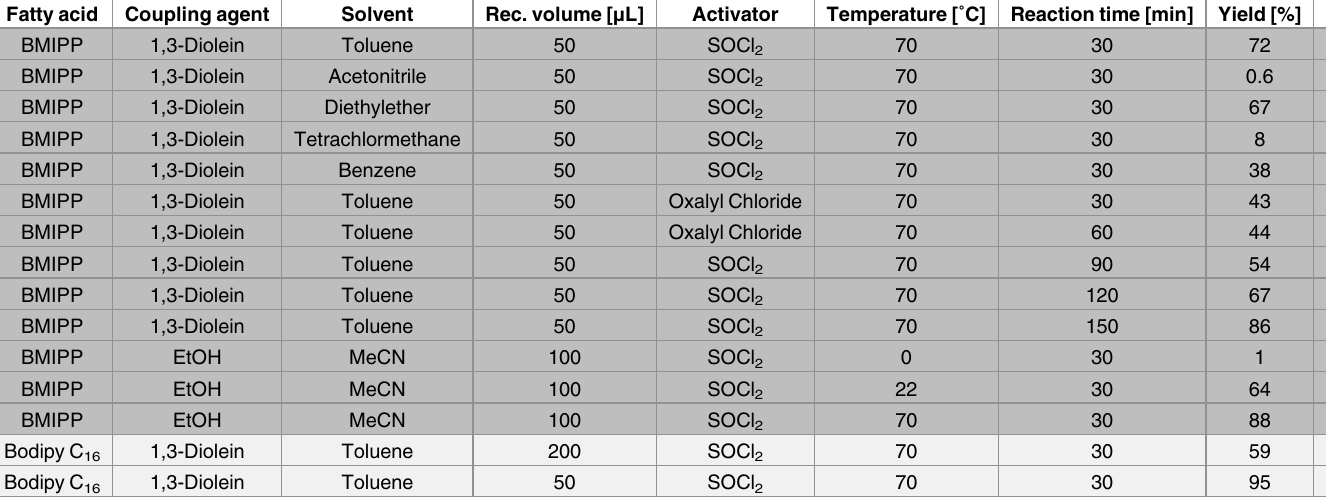
Table 1. Different esterification conditions for BMIPP or BDP-C16. Yields tested by injectionof the crude reaction mixture into HPLC and comparisonof the esterified vs. the non-esterified FA signalplus byproducts.